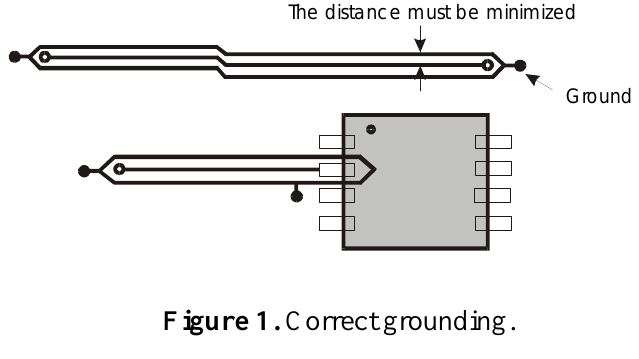
Figure 1. Correct